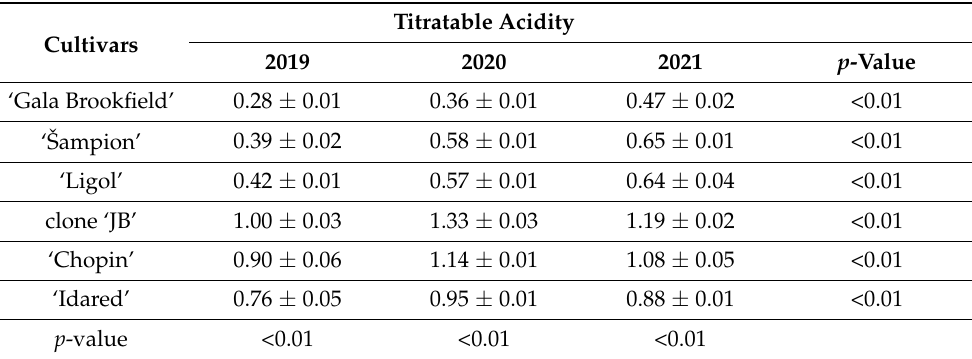
Table 5. The values of titratable acidity (%) for apples depending on cultivars and years of testing.